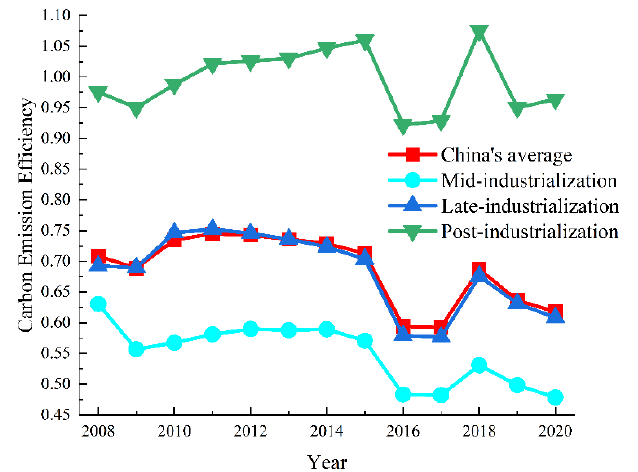
Figure 1. CEE at different industrialization stages.